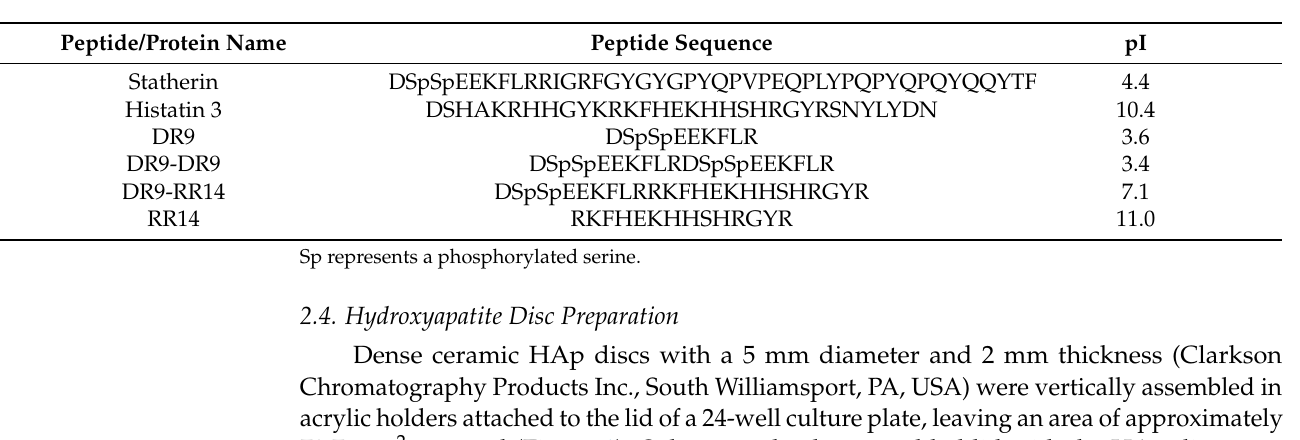
Table 1. Constructed peptides derived from statherin and histatin and their calculated isoelectric points (pI).